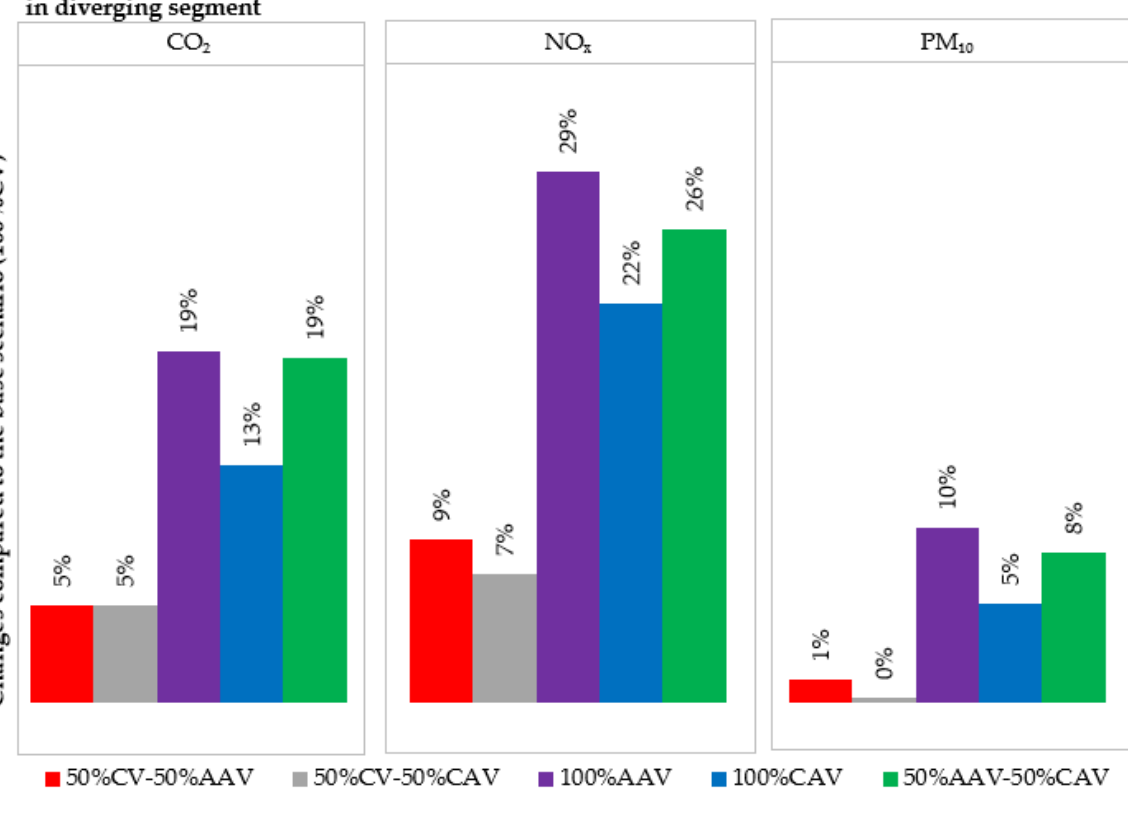
Table 5. Traffic flow characteristics and traffic emissions for the weaving segment.